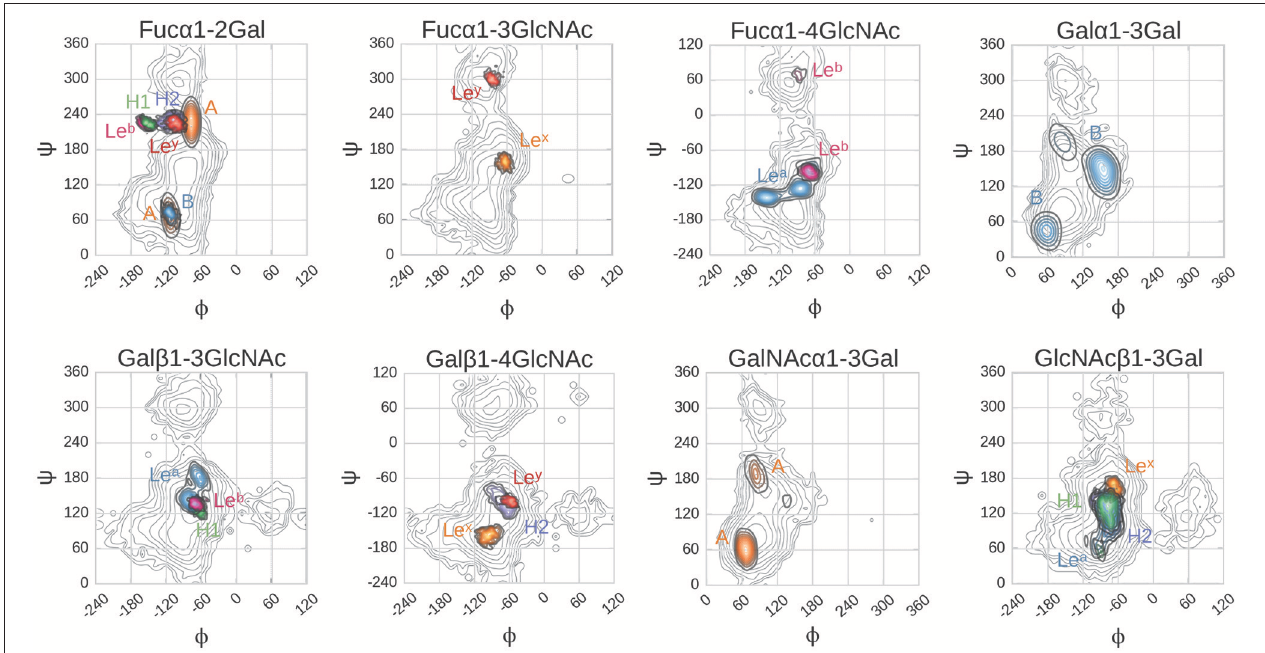
FIGURE 7 | Glycosidic dihedral angles in BambL-blood group saccharide complexes during MD simulations. Dihedrals are defined as: ϕ , O 5 -C 1 -O 1 -C x ; ψ , C 1 -O 1 -C x -C x + 1 . Contour plots color coding: gray, calculated energy landscapes of constituting linkages; brown, A; light blue B; green H1; dark blue, H2; cyan Le a ; pink, Le b ; orange Le x ; red Le y . Contour plot lines mark intervals of 1